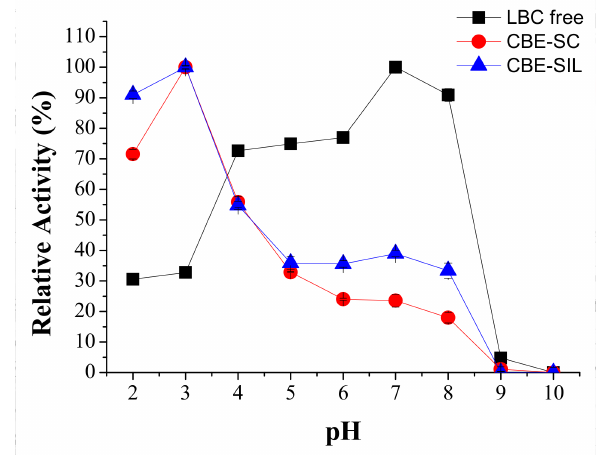
Figure 1. Effects on relative activity under various pH and temperature values. Ranging from pH 2 to pH 10 at 37 °C for lipase from Burkholderia cepacia free (LBC) ( ■ ), lipase immobilized by covalent binding with epichlorohydrin onto support produced without ionic liquid (CBE ‐ SC) ( ● ), lipase immobilized by covalent binding with epichlorohydrin onto support produced with IL (CBE ‐ SIL) ( ▲ ).